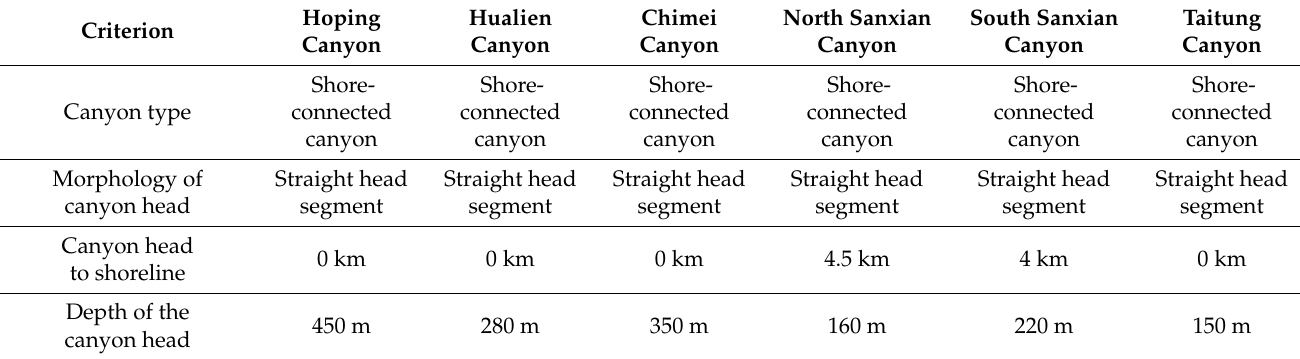
Table 4. Comparisons of submarine canyons along the East Taiwan